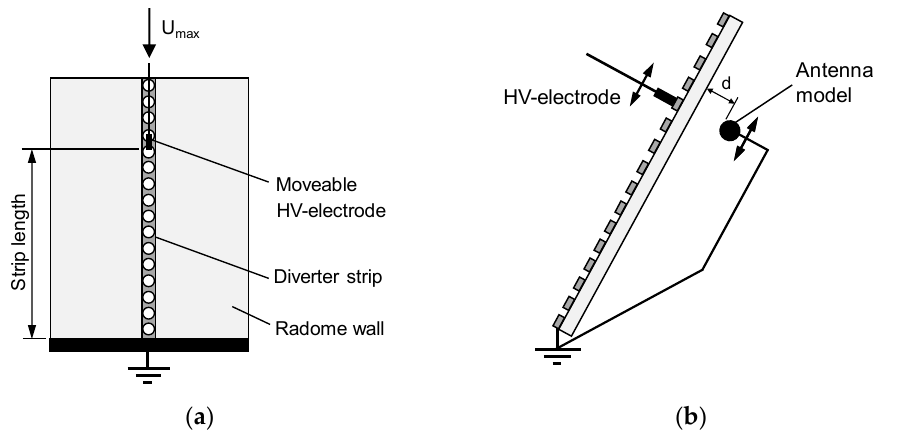
Figure 7. Schematic drawing of the test setup for the evaluation of the admissible length of the diverter strip: ( a ) top view and ( b ) from the side.